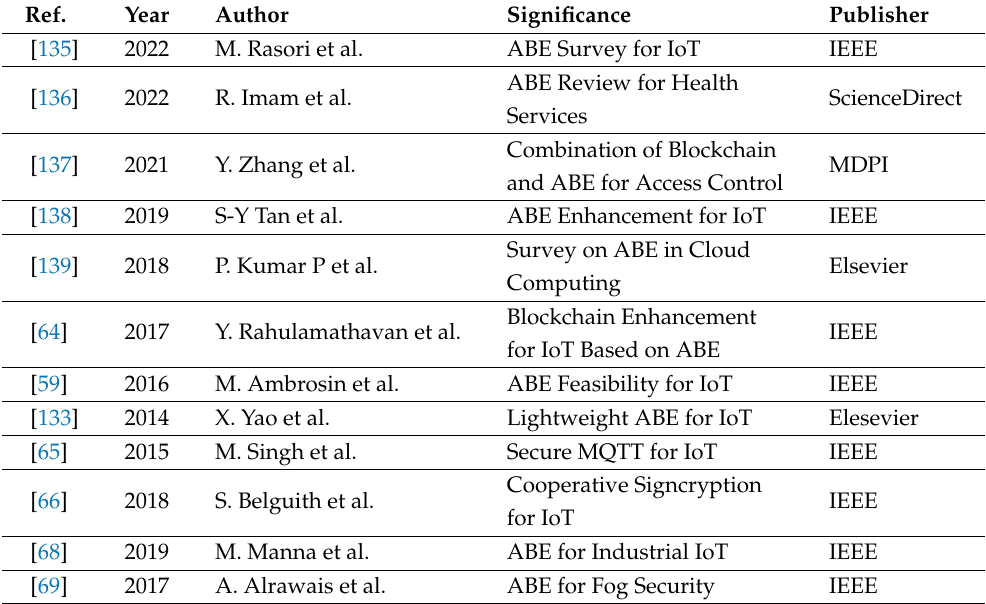
Table 2. Significant IoT-related literature for ABE in the last decade.